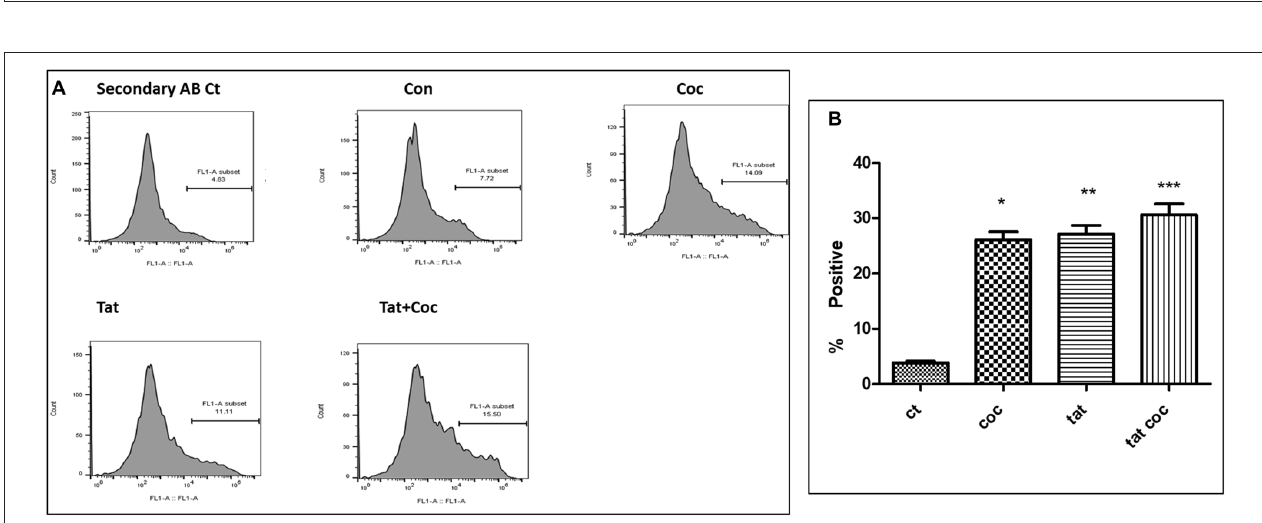
FIGURE 8 | Tat and coc combination. (A) Tat (50 ng/mL) and coc (0.1 µ M) individually and in combination increase the A β 1–40 levels. The cells were treated with selected Tat and coc concentrations and combination of both, and after 48 h of treatment were analyzed by flow cytometry for determining the A β 1–40 levels. (B) Quantification representation of the percent positive cells ( ∗ p ≤ 0.05; ∗∗ p ≤ 0.01; ∗∗∗ p ≤ 0.001).